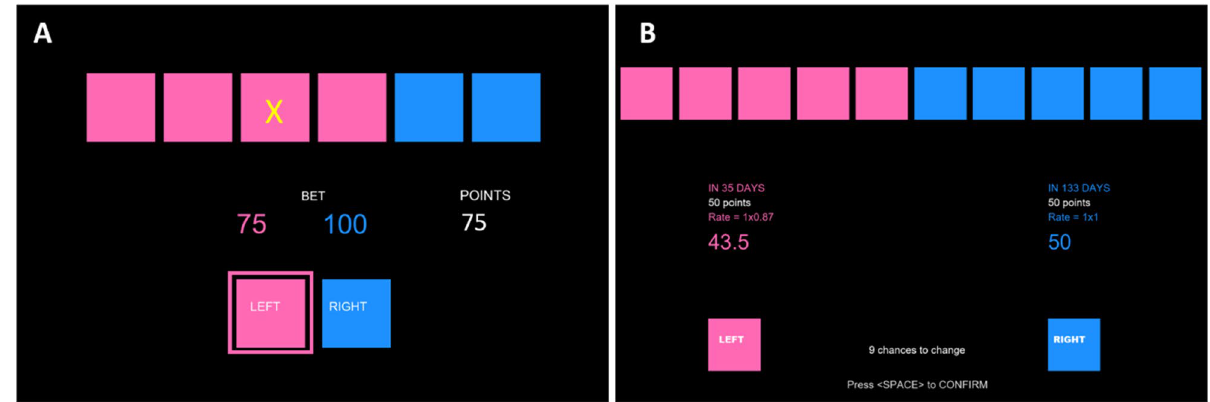
Figure 3. Example screens of the tasks used. ( A ) Displays an example screen from the Maastricht Gambling Task (MGT), and ( B ) an example screen from the Maastricht Choice Game were made on the dates specified in a randomly chosen trial in MCG. We used this method so that all MCG payments could be done in the same way without participants having to come back to the lab. The second part of the payment, including their participation reward, at the rate of €7.5 per h, plus rewards to the randomly chosen trial in MGT was made using vouchers with monetary value. This was done at the end of the experiment (end of session 2).